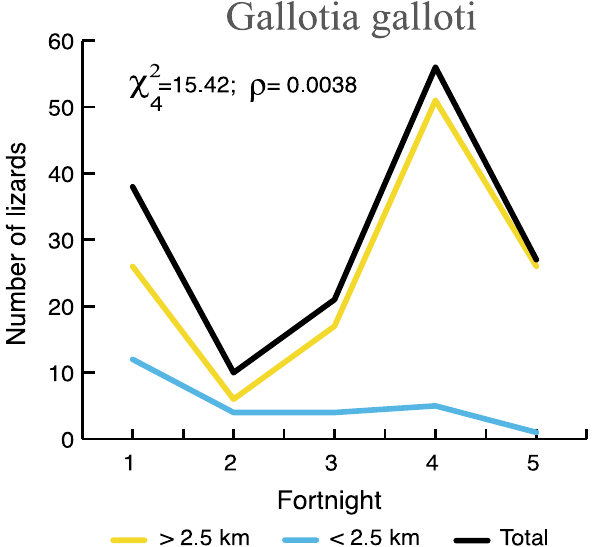
Figure 3. Time sequence in abundance of the endemic lizard Gallotia galloti sightings during the Tajogaite volcanic eruption and their distances from the crater (within or beyond 2.5